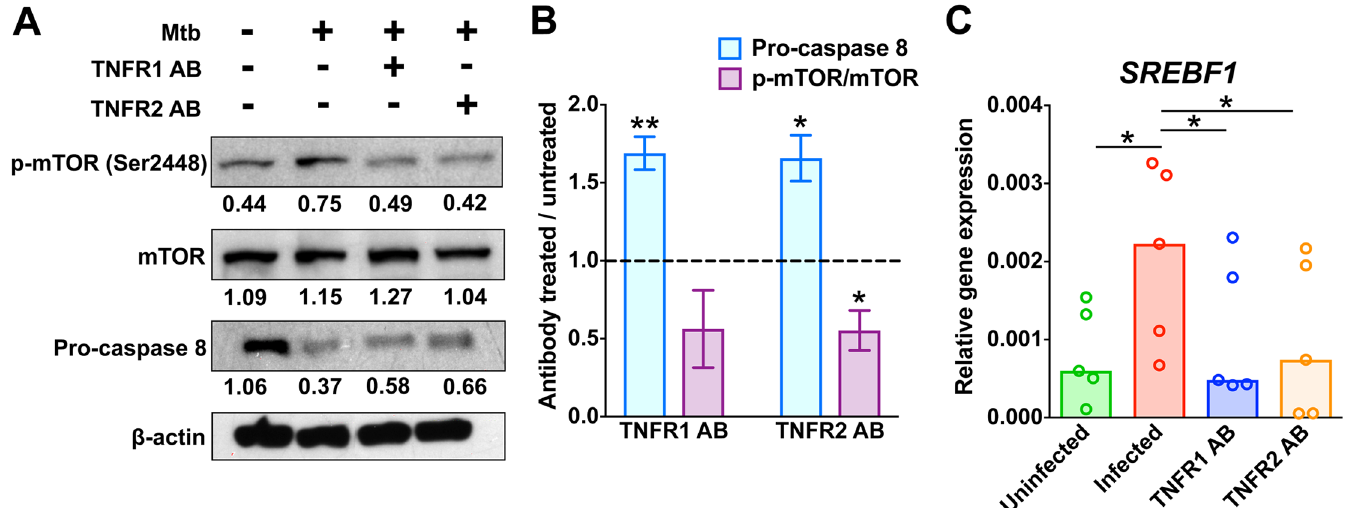
Fig 6. Effects of TNFR neutralizing antibodies on mTORC1 and caspase activity. MDM were treated with antibodies against TNFR1 or TNFR2 prior to infection. After 24 h of infection, whole cell lysates and RNA were obtained. ( A ) Analysis of phosphorylation state of mTORC1 and abundance of pro-caspase 8 by western blot. p- mTOR, band reacting with an antibody specific for mTOR phosphorylated at Ser-2448; mTOR, band reacting with an antibody recognizing total mTOR protein. Western blot bands were quantified by using ImageJ software. Numbers below each band indicate the intensity ratio of the test band relative to β -actin (loading control). Full-length blots are presented in S8 Fig. ( B ) Quantification of the western blot data in panel A. The graph shows the effect of TNFR antibody treatment (treated vs untreated) on the ratios of p-mTOR/mTOR and procaspase 8 abundance. The average and standard deviation for three donors is shown. ( C ) Gene expression analysis. Methods are described in the legend to Fig 3. The graph shows the median of five donors, with each dot representing one donor. Statistical significance ( (cid:3) p < 0.05, (cid:3)(cid:3) p < 0.01) was assessed by one-sample (panel B ) and paired (panel C ) student t-tests. The comparisons in the paired tests are as indicated; the comparison in the one- sample student t-test was between treated and untreated cells. [It is noted that the decrease of 50% in the ratio of p-mTOR/mTOR observed with the anti-TNFR1 antibody treatment did not reach statistical significance ( p = 0.09)]. Mtb: M . tuberculosis , TNFR1 AB: TNFR1 neutralizing antibodies, TNFR2 AB: TNFR2 neutralizing antibodies.